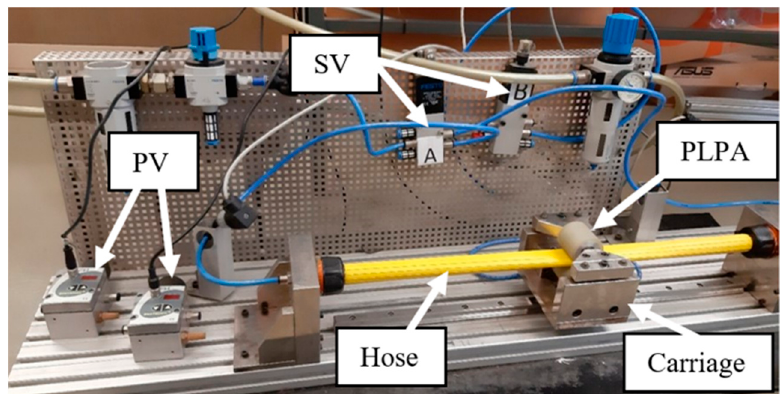
Figure 3. Experimental setup.